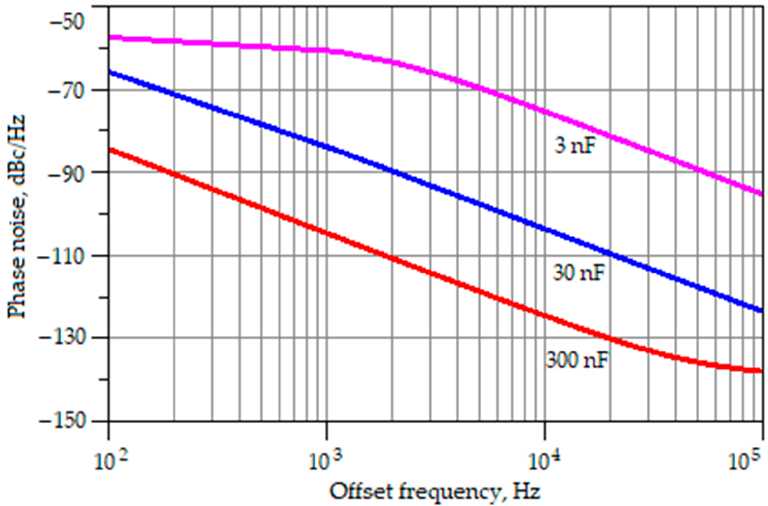
Figure 25. Phase noise versus offset frequency for the VCO with multiple-output improved Wilson current mirror when V d = 2 V, R L = ∞ , and C a = 6 pF; C b = 3 nF—purple curve, C b = 30 nF—blue curve, C b = 300 nF—red curve.